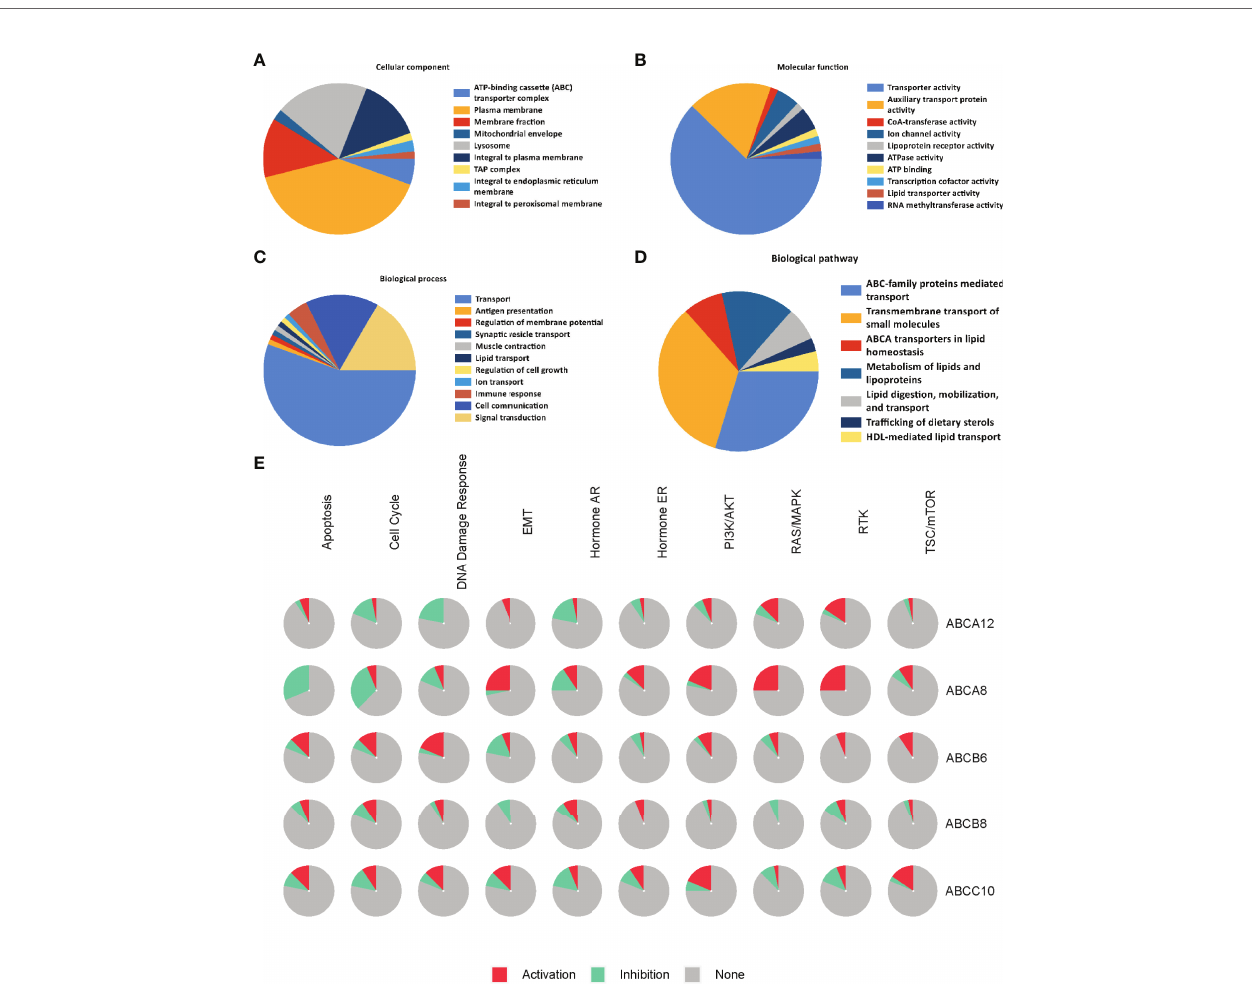
FIGURE 7 | Functional and pathway enrichment analysis of the fi ve hallmark ABC transporters in TC. (A) The most enriched cellular components of correlated genes of the fi ve hallmark ABC transporters. (B) The most enriched molecular functions of correlated genes of the fi ve hallmark ABC transporters. (C) The most enriched biological processes of correlated genes of the fi ve hallmark ABC transporters. (D) The most enriched biological pathways of correlated genes of the fi ve hallmark ABC transporters. (E) The cancer related pathway enrichment of the fi ve hallmark ABC